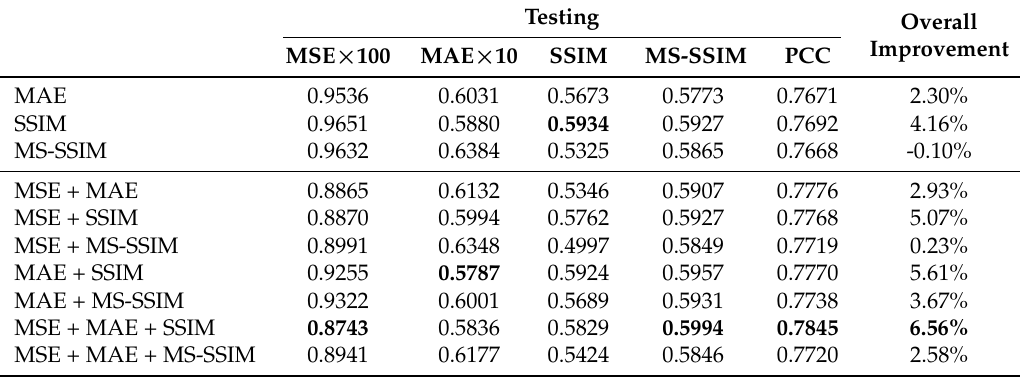
Table 3. Testing performances of the dec-TrajGRU model trained with different loss functions. For convenience, we used the “+” sign to denote the combination. The overall improvement is the averaged percentage of advantages in the synthetic comparison with the dec-TrajGRU model trained with only MSE in Section